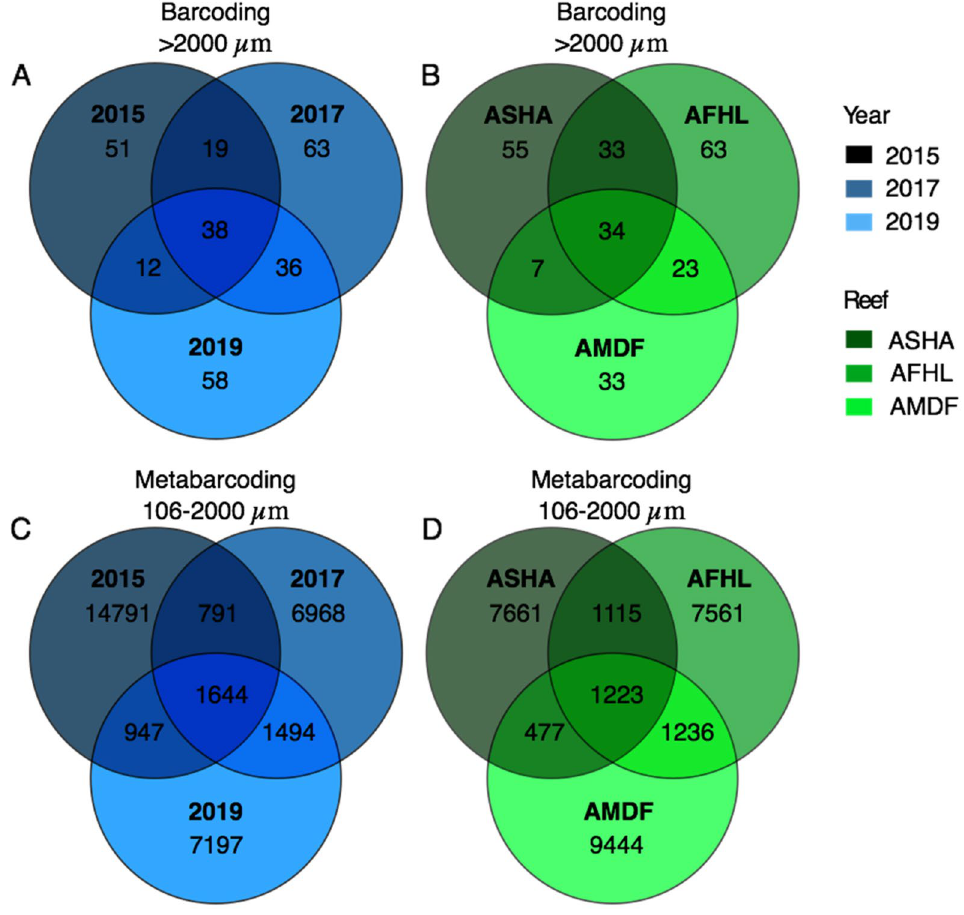
Figure 1. Venn diagrams showing the number of OTUs of the > 2000 µm fraction unique to each time ( A ) and reef ( B ) and the shared between them. ( C ) and ( D ) show the number of ASVs of the metabarcoded 106– 2000 µm fraction unique and shared between time ( C ) and reef ( D ). ASHA stands for Abu Shoosha reef, AFHL for Al Fahal, and AMDF for Abu Madafi. 2015, 2017, and 2019 are the dates of the recovery of the ARMS and correspond to the deployment periods of 2013–2015, 2015–2017 and 2017–2019,